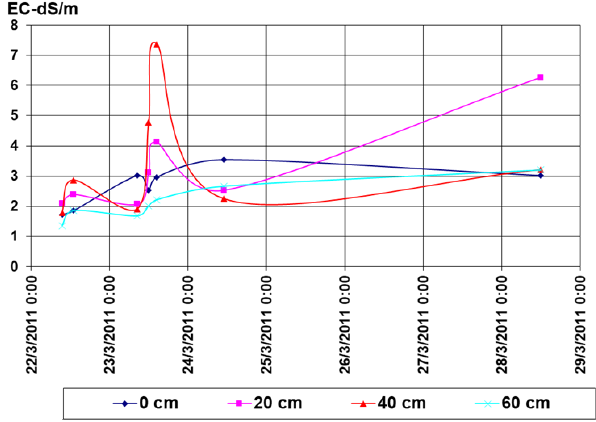
Figure 9. Soil salinity at different soil profile depths measured at the first tensiometer station.